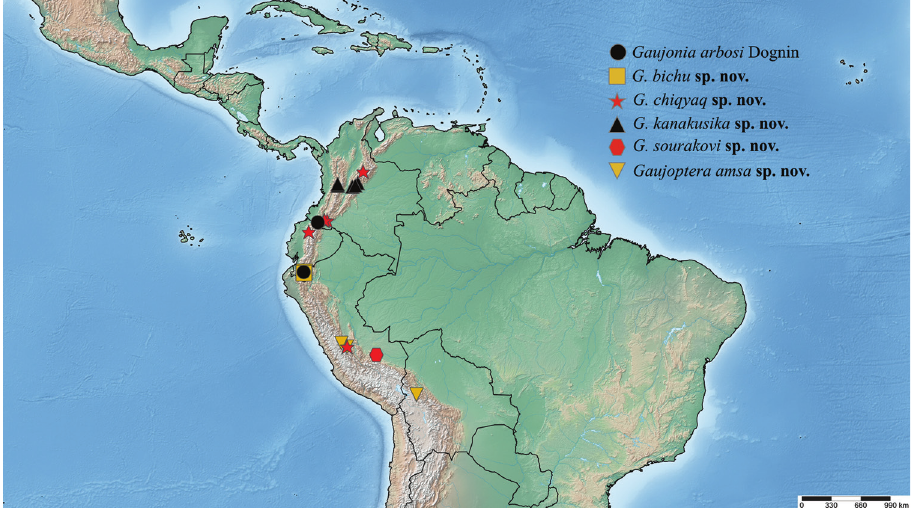
Figure 93. Distribution of examined specimens of the genera Gaujonia and Gaujoptera . Oculicattus uturunku sp. nov. http://zoobank.org/6C34E855-780E-4A8F-9BF5-C1E39FE26236